Question: State the chart type depicted above.
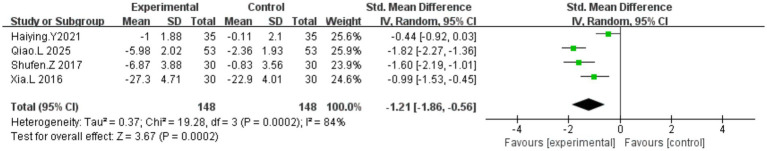
Answer: forest